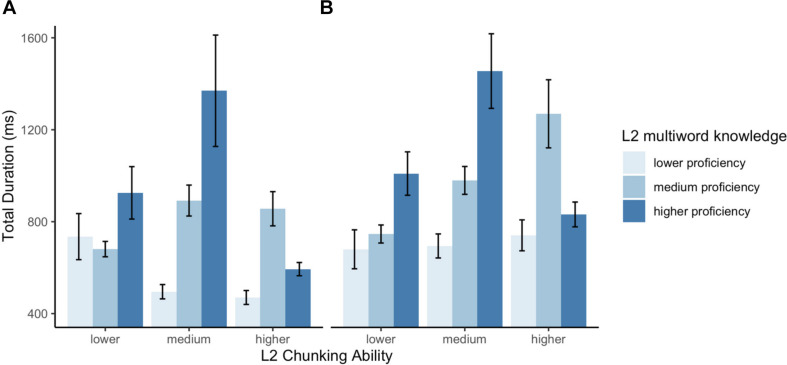
Effects of L2 chunking ability and multiword knowledge on verb total duration times for in (A) congruent and (B) incongruent multiword units. Levels of L2 chunking ability are represented in the horizontal axis, and levels of L2 multiword knowledge are shown in column colors. L2 multiword knowledge serves as the critical L2 proficiency measure. Error bars represent the standard error.